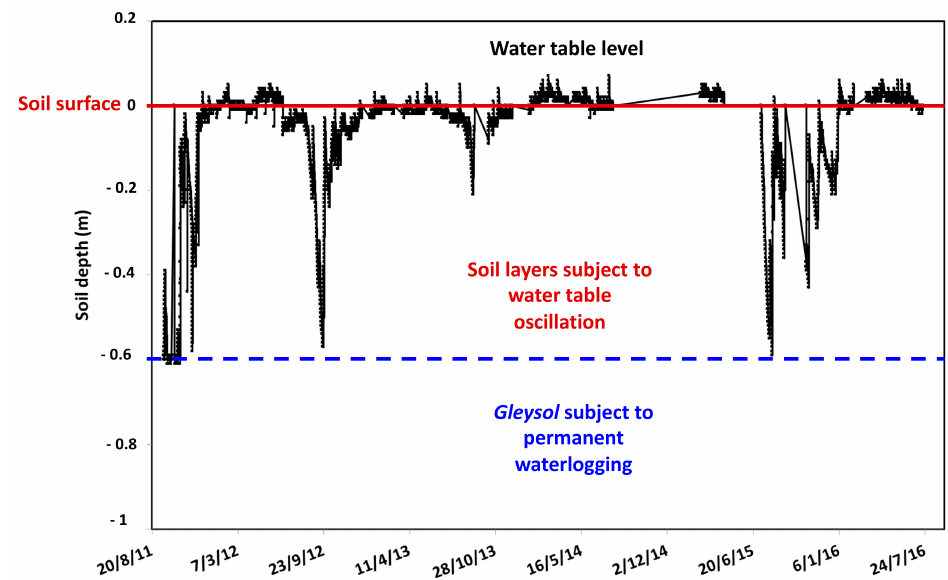
Figure 1. Water table variations in the studied wetland soil. The piezometer was installed at a 60-cm